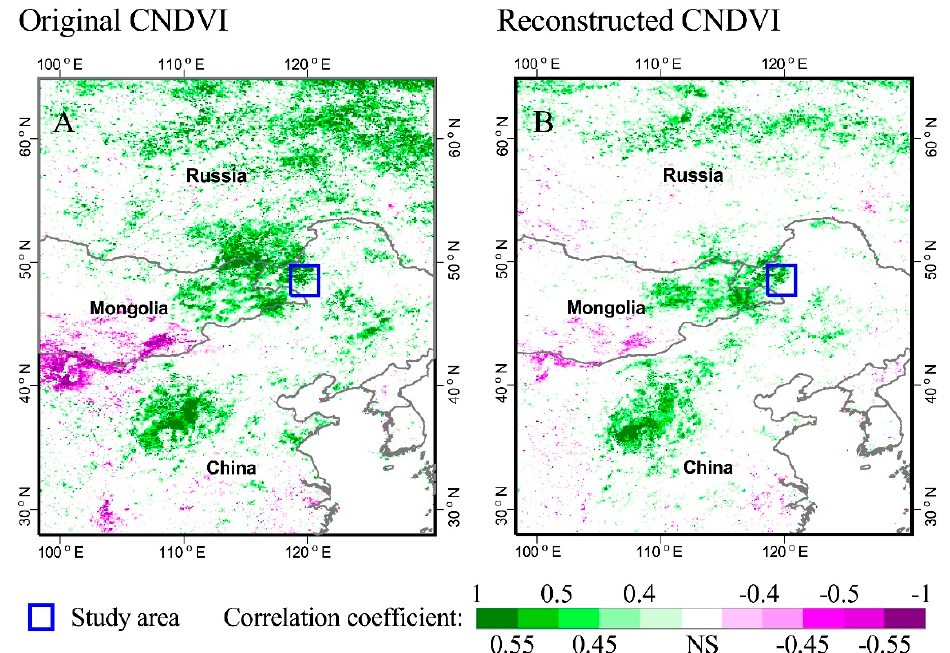
Figure 7. Spatial correlation patterns between the original ( A ) and reconstructed ( B ) CNDVI JJ in the CW–DHM region and the GIMMS CNDVI JJ during the period 1982–2013 CE. NS represents non-significant.